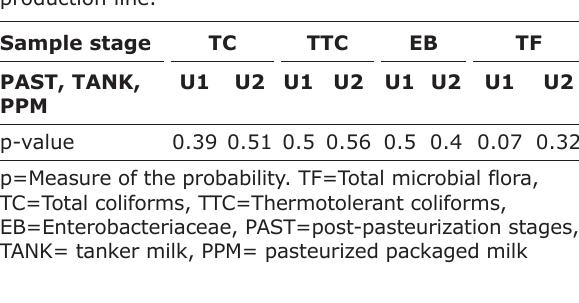
Table-4: Assessment of the step parameter and indicators. Indicator